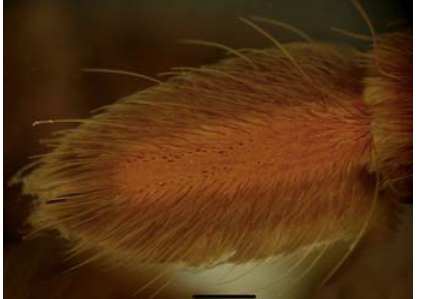
Image 16. Claw I. Scale 1.0mm